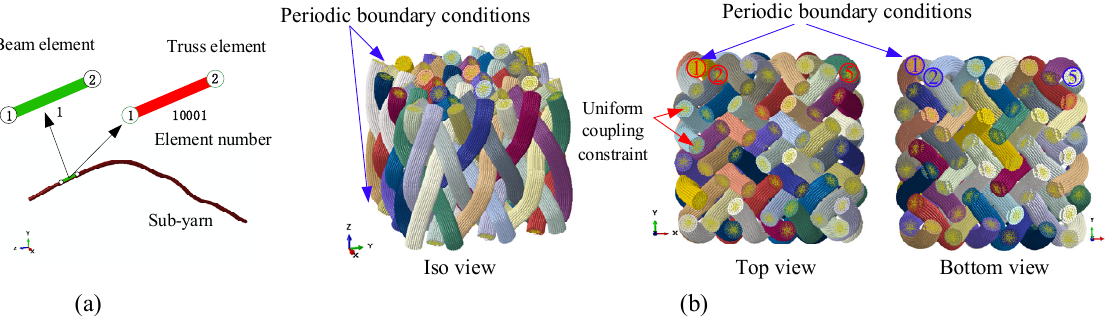
Figure 8. The FEA model of the yarn deformation simulation: ( a ) the hybrid element and ( b ) the periodic boundary condition. periodic boundary